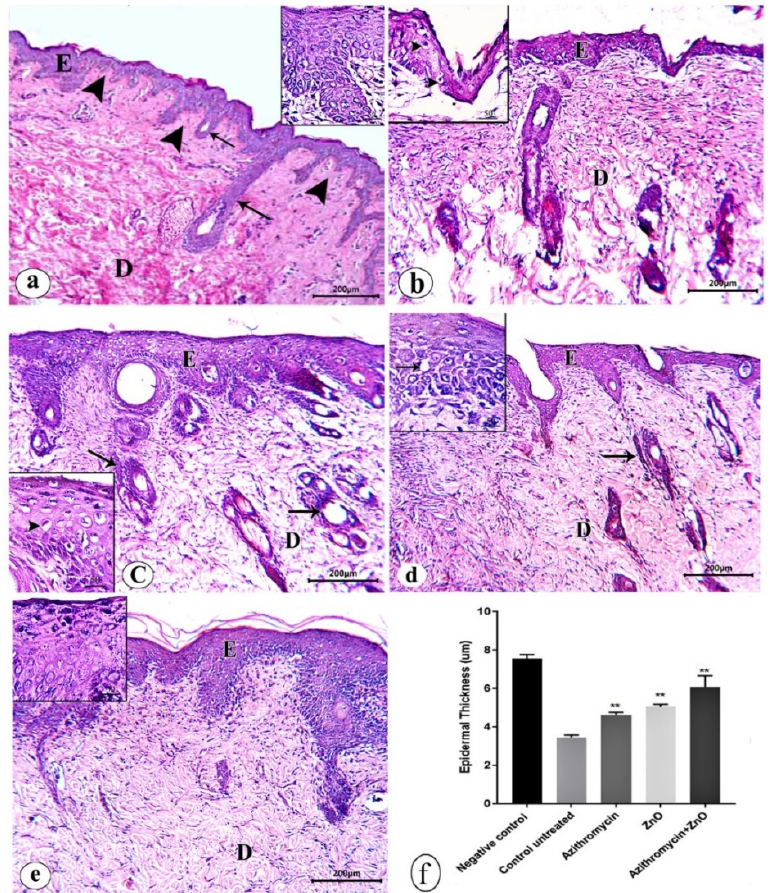
Figure 10. Hematoxylin-and-eosin-stained sections of skin from rats from all groups. ( a ) Negative control group, ( b ) untreated control group, ( c ) AZM-treated group, ( d ) zinc oxide-treated group, ( e ) AZM-ZnONP-treated group, and ( f ) mean epidermal thickness of skin in different groups. Data are expressed as mean ± SD. p -values were calculated with the Mann–Whitney test. ** p value < 0.005. Insets represent magnified sections. Epidermis (E), dermis (D), dermal–epidermal junction (arrowhead), and hair follicles (arrow).